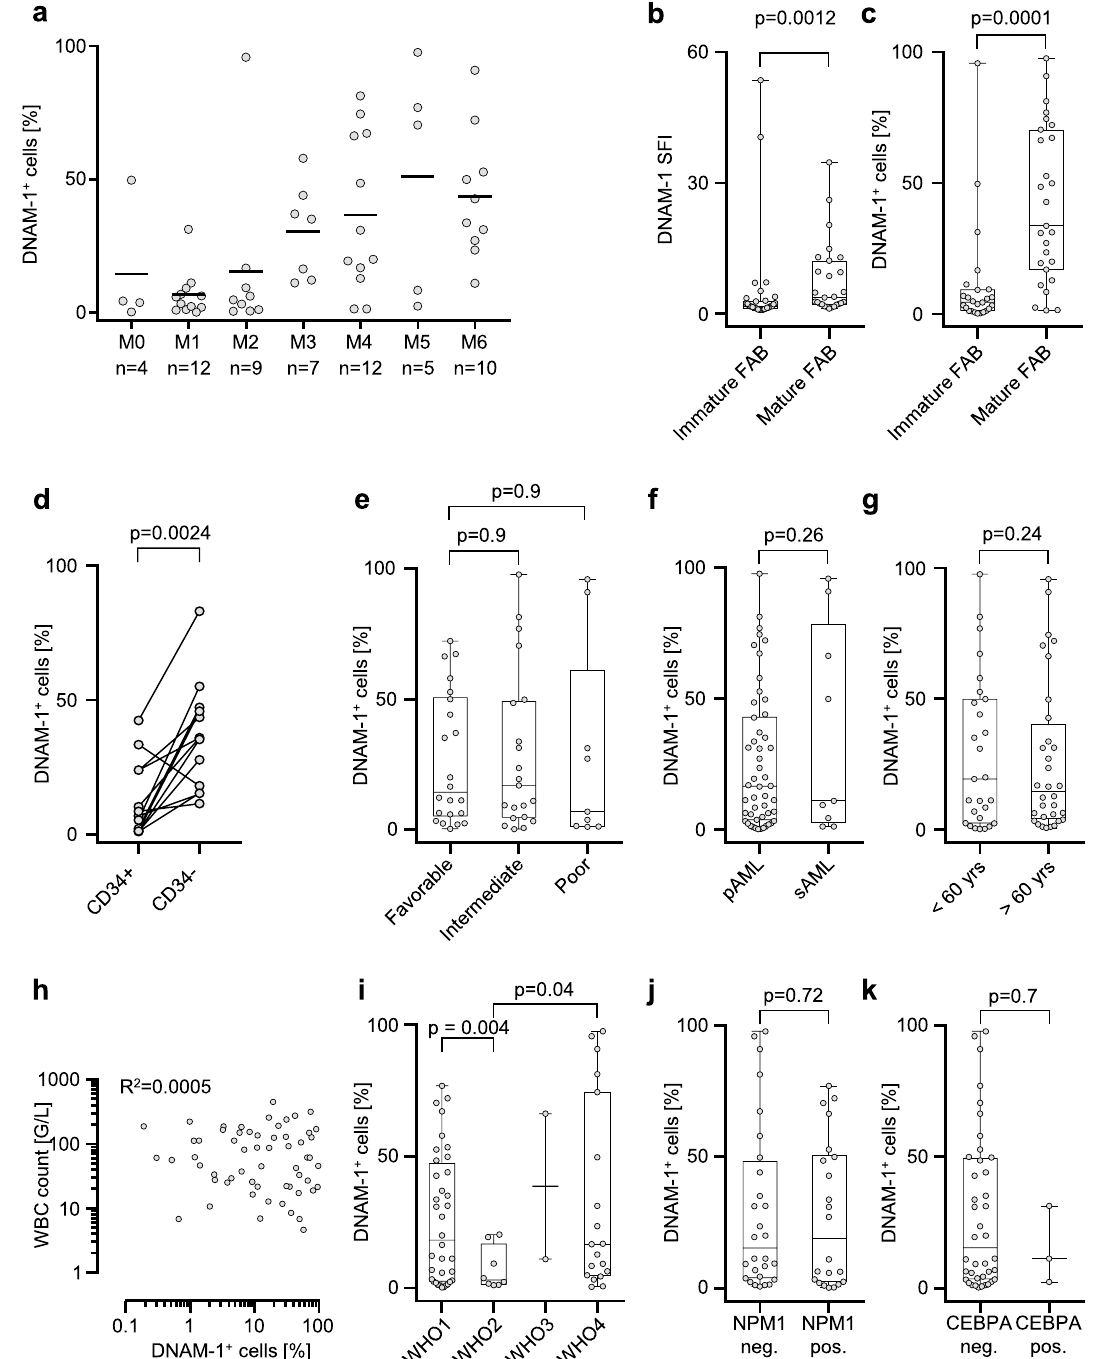
Figure 3. DNAM-1 expression is associated with clinical parameters. ( A ) Proportion of DNAM-1 + cells in AML samples grouped according to the FAB subtype; median and individual values are shown. ( B – C ) Distribution of DNAM-1 expression in immature (M0-2) versus mature (M4–M6) FAB subtypes is shown; statistical significance was assessed using Mann–Whitney test. (D) Distribution of DNAM-1 + cells among CD34 + and CD34 - populations of AML blasts is depicted. Values derived from the same sample are connected with lines; n = 12, statistical significance was assessed using Wilcoxon paired rank test. ( E – G ) Distribution of DNAM-1 expression (% of positive cells) across NCCN risk groups ( E ), primary (pAML) and secondary (sAML) cases ( F ), and two age groups ( G ) is demonstrated. ( H ) Correlation of DNAM-1 expression with WBC counts is illustrated. ( I – K ) Distribution of DNAM-1 expression across AML types based on WHO classification ( I ), AML cases positive or negative for NPM1 and CEBPA mutations ( J , K ) is shown. Statistical significance was assessed using Mann–Whitney ( D , G , J , K ), Kruskal–Wallis ( E , F ) or Brown–Forsythe and Welch ANOVA ( I ) tests. Rs, Spearman correlation